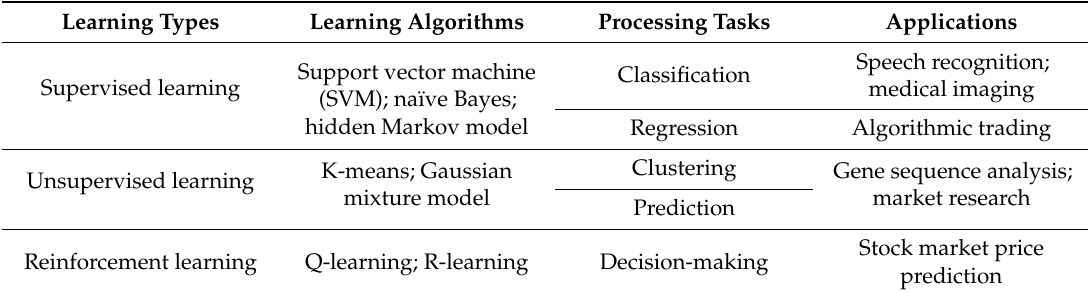
Table 13. Sub-domains of machine